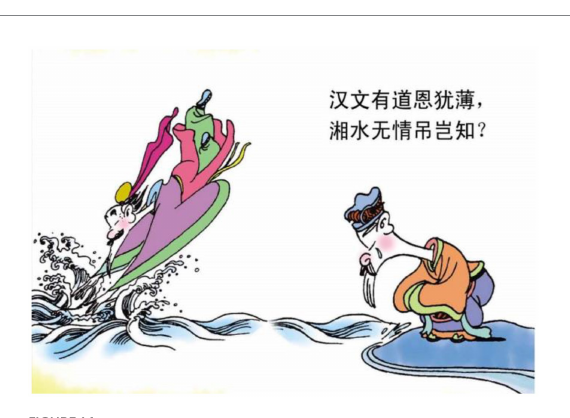
FIGURE 14 The forth panel on Cai (2014, p. 52). Images reproduced with permission from Shang Dong People